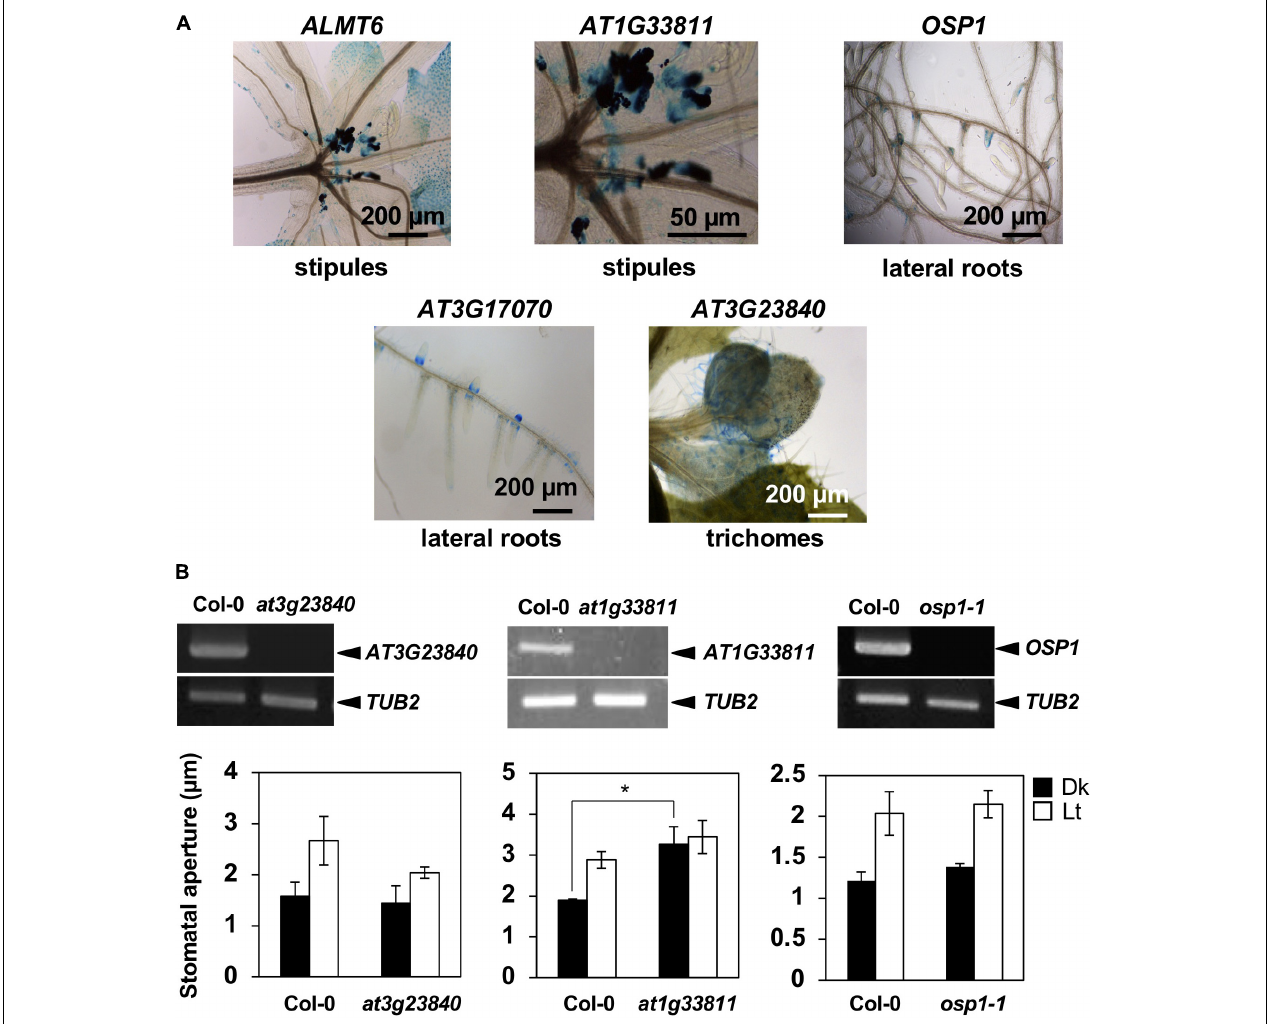
FIGURE 3 | Expression patterns of GC-preferentially expressed genes and the stomatal phenotypes of knockout mutants. (A) Gene expression in tissues other than stomata as revealed by the GUS-reporter assay. (B) Upper panels show the RT-PCR of target genes. Lower graphs show BL-induced stomatal opening in at3g23840 , at1g33811 , and osp1-1 null mutants. Epidermal tissues ( at3g23840 and at1g33811 mutants) or leaf disks ( osp1-1 mutant) were incubated in 50 mM KCl, 0.1 mM CaCl 2 , and 10 mM Mes-BTP (pH 6.5). Dark bars, dark treatment for 3 h (Dk); white bars, light treatment for 3 h (RL, 50 µ mol m − 2 s − 1 ; BL, 10 µ mol m − 2 s − 1 ) (Lt). Average values from three independent experiments are shown. Error bars: SDs ( n =